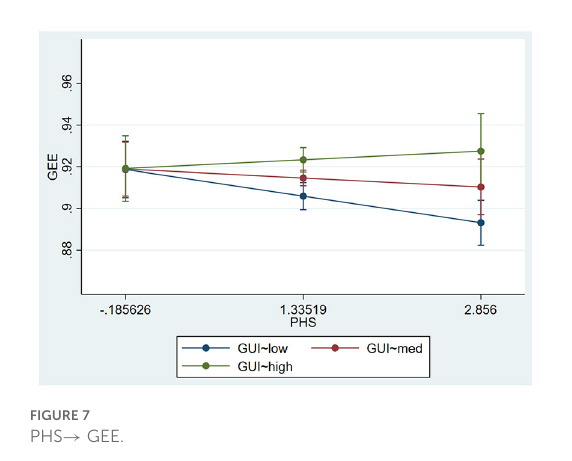
TABLE 8 Conditioning inspection results.